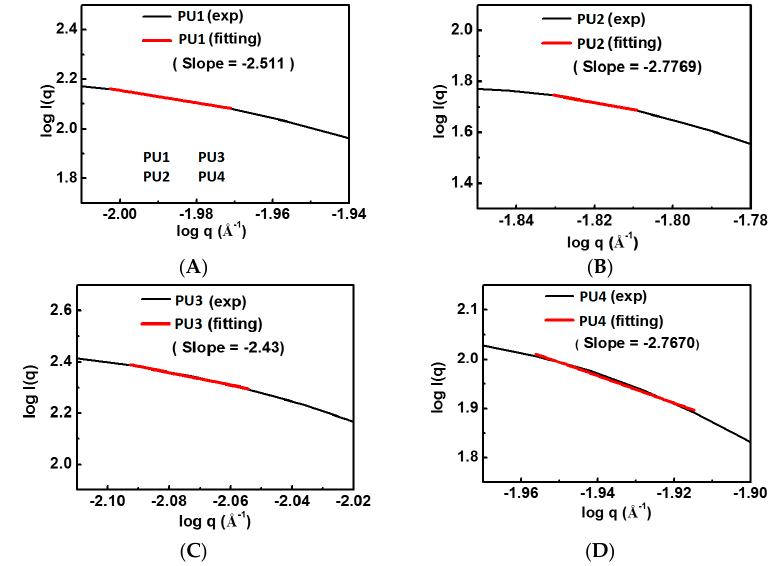
Figure 4. SAXS profiles of various PU dispersions at 25 °C: ( A ) PU1; ( B ) PU2; ( C ) PU3; and ( D ) PU4.